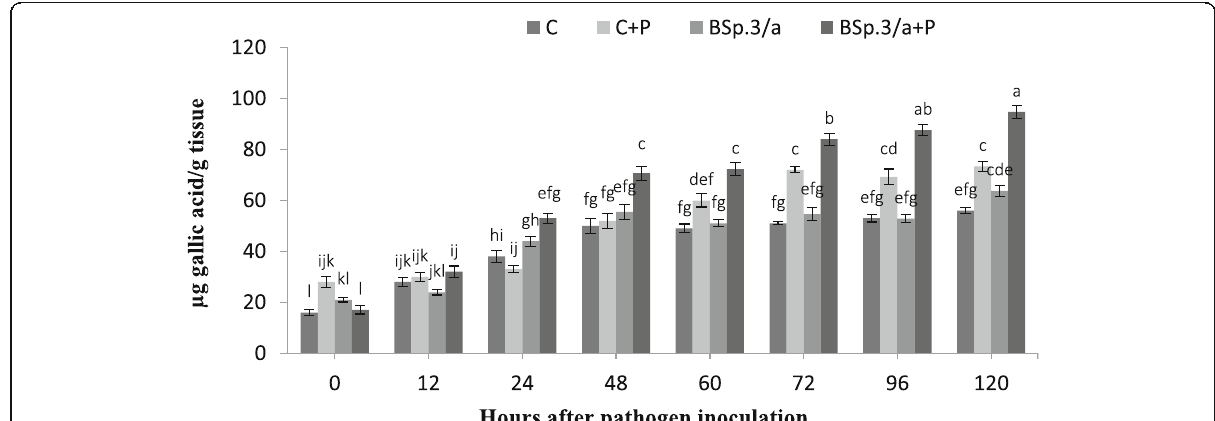
Fig. 5 Influence of PGPR strain BSp.3/aM on phenolic